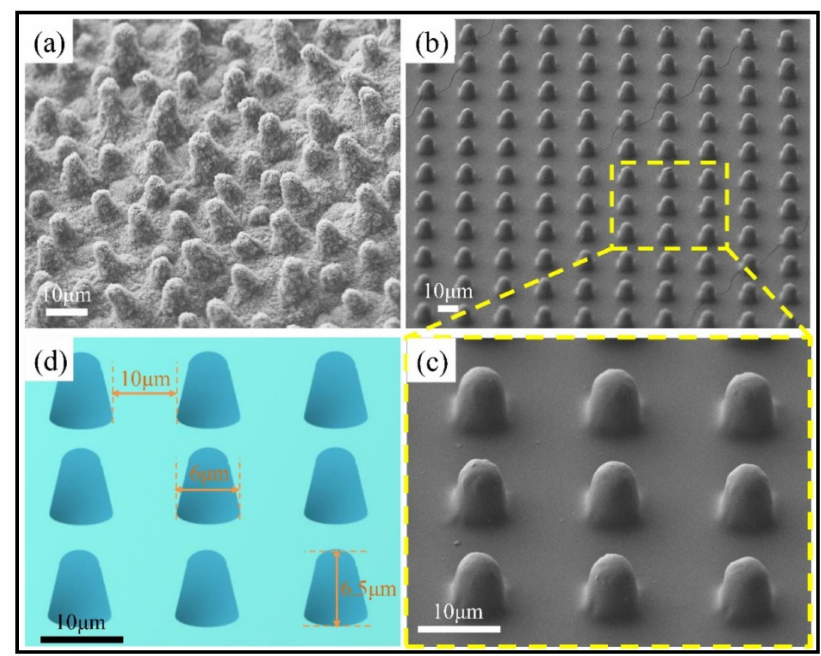
Figure 3. ( a ) The microscale papillae surface of the lotus leaf; ( b ) low-magnification FESEM image demonstrates overall morphology of the PMAs-based BPF; ( c ) enlarged FESEM image further demon- strates the high quality and uniformity for microstructures of the biomimetic PMAs; ( d ) a 3D image of the PMAs illustrates the global layout of the PMAs.